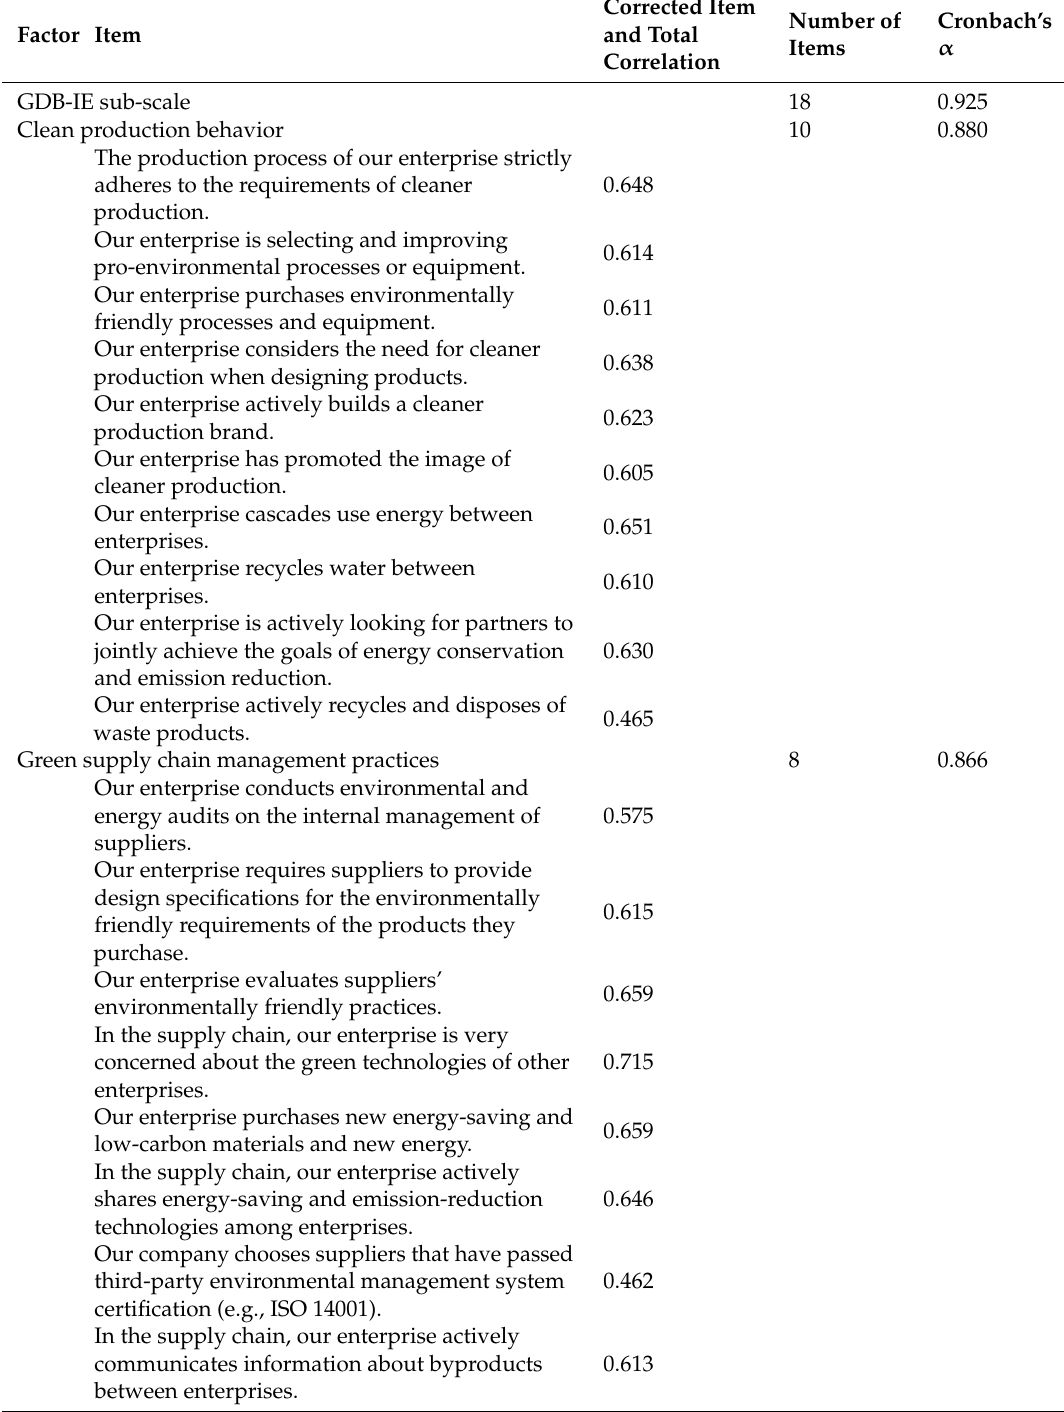
Table 9. Reliability test results of the GDB-IE sub-scale ( N =